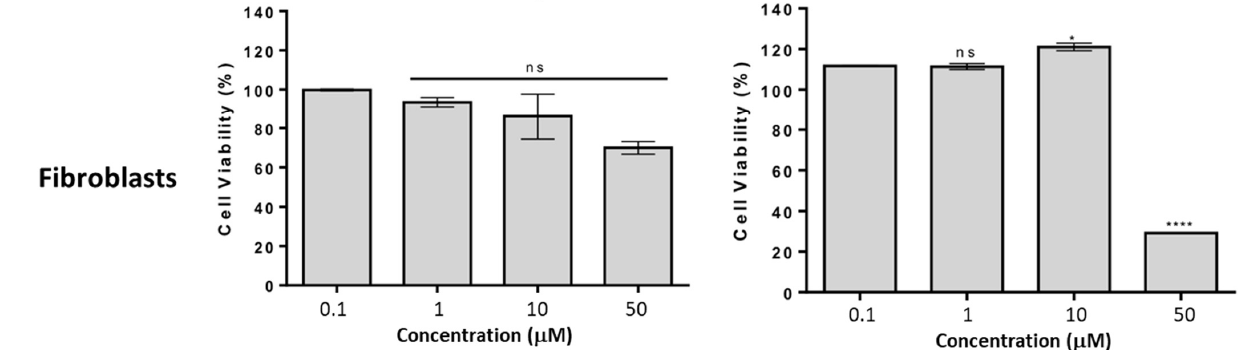
Figure 1. Antiproliferative activity of JHOR10 and JHOR11 after 48 h in A2780, HCT116 and Doxorubicin-resistant HCT116 (HCT116-Dox) cell lines and in normal human dermal fibroblasts. Data were normalized to the control (0.1% ( v / v ) DMSO) with bars representing the mean ± SD of at least three independent experiments. * p value < 0.05, ** p value < 0.01, *** p value < 0.005, **** p value < 0.0001, n.s. not significant. Table 1. Relative IC 50 (in µ M) after 48 h of incubation of complexes JHOR10 and JHOR11 in A2780, HCT116 and HCT116-Dox cell lines and in normal human dermal fibroblasts. n.d.—not determined. IC 50 ( µ M) Complexes A2780 HCT116 HCT116-Dox Fibroblasts JHOR10